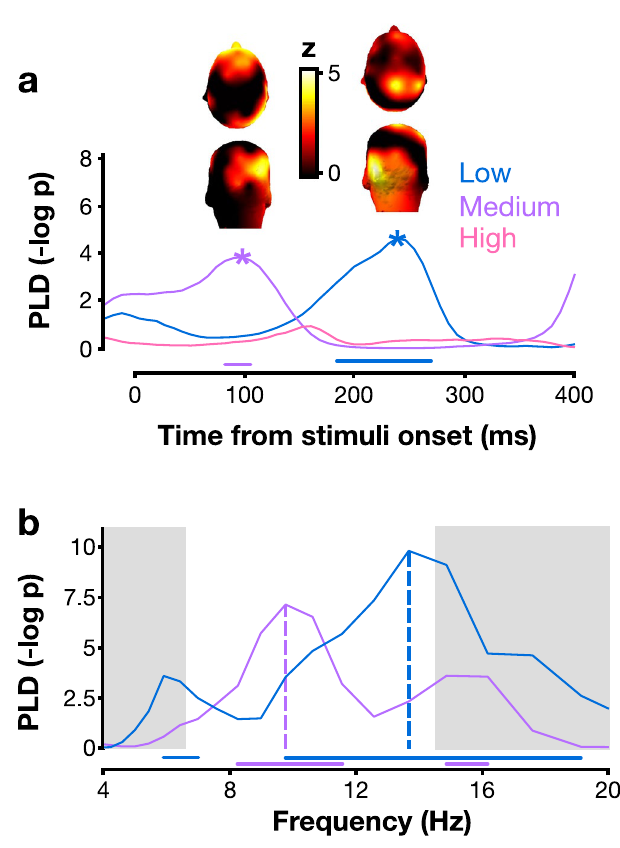
Figure 3. Post-stimulus phase-locking difference between correct and incorrect trials in Experiment 1. ( a ) The phase-locking difference (PLD) is the difference in inter-trial phase coherence (ITC) between correct and incorrect trials. The PLD curves are plotted after averaging across the frequency range of the significant clusters found in pre-stimulus phase opposition (Fig. 2). Stars mark the timepoint of maximum significance on each trace (medium: 98 ms; low: 238 ms). Topomaps represent the PLD at each electrode averaged across participants at the timepoint of maximum significance. ( b ) PLD curves plotted at the timepoints of maximum significance against frequency for the medium (in purple) and low (in blue) discriminability conditions. The white area indicates the frequency range of interest, taken from the pre-stimulus phase opposition effect. On both panels, horizontal bars along the bottom indicate that the PLD of the corresponding curve (blue: low discriminability; purple: medium discriminability) is above the significance threshold corrected for multiple comparisons